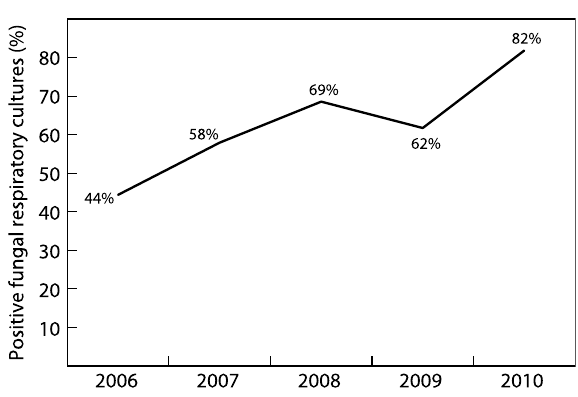
Figure 1: Respiratory fungal culture positivity